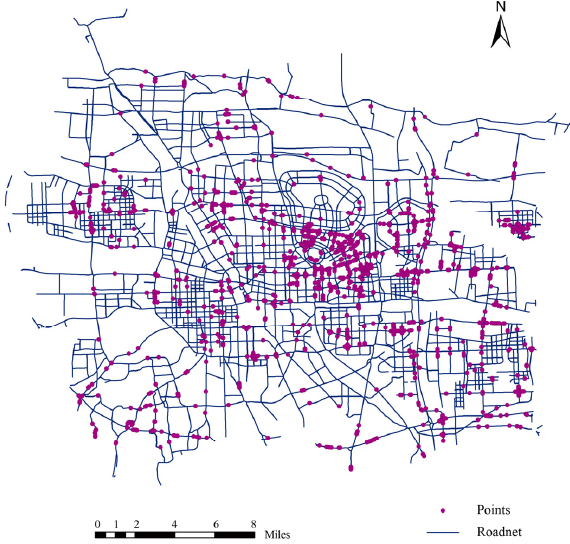
Figure 11. Map highlighting “LH” points in Zhengzhou, China.